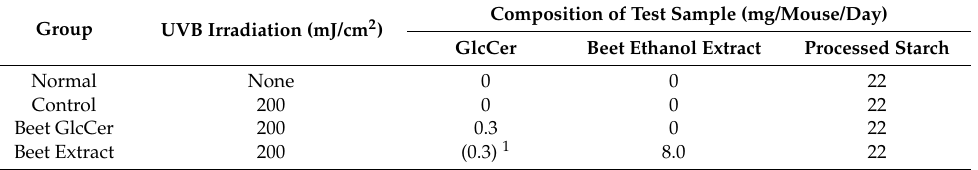
Table 1. Experimental groups and test